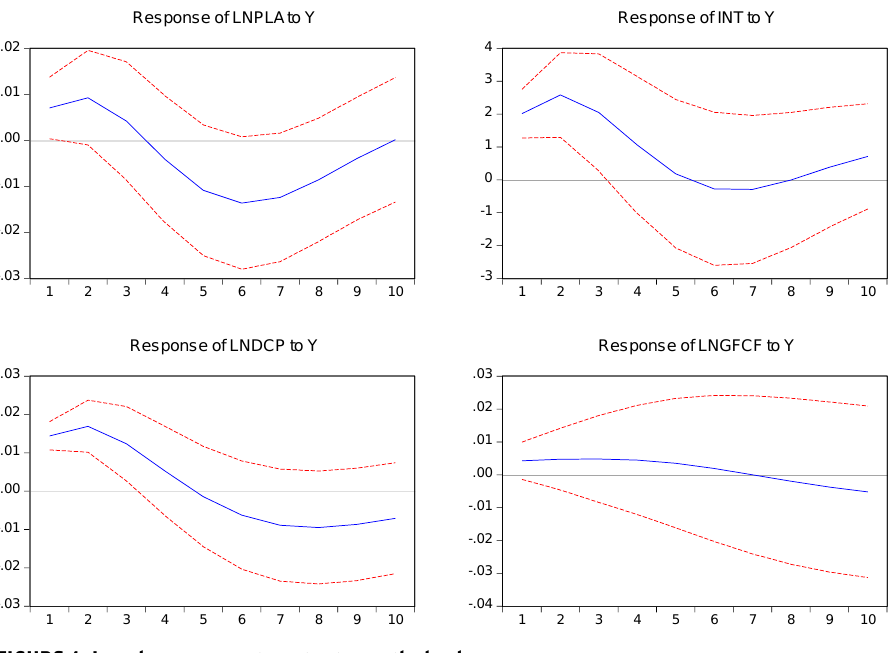
FIGURE 4: Impulse response to output growth shock PLA: Potential Liquidity Available; INT: Real Interest Rate; DCP: Domestic Credit to Private Sector; GFCF: Gross Fixed Capital Formation; Y: GDP growth